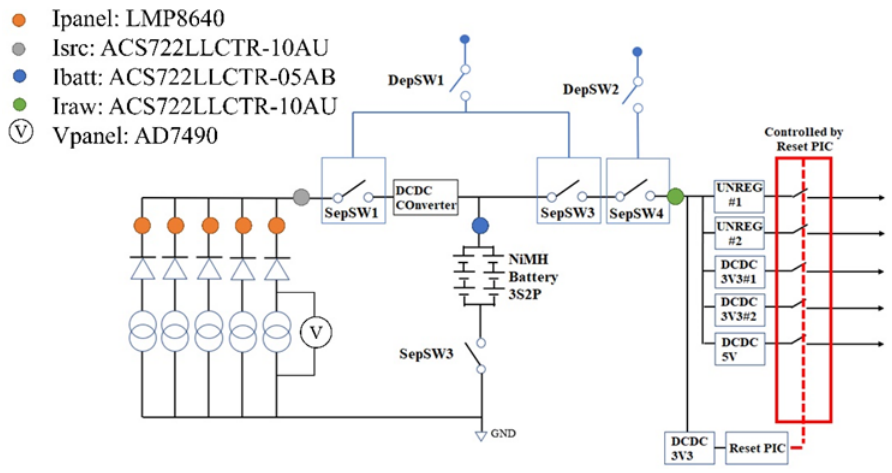
Figure 3. EPS block diagram with power distribution.